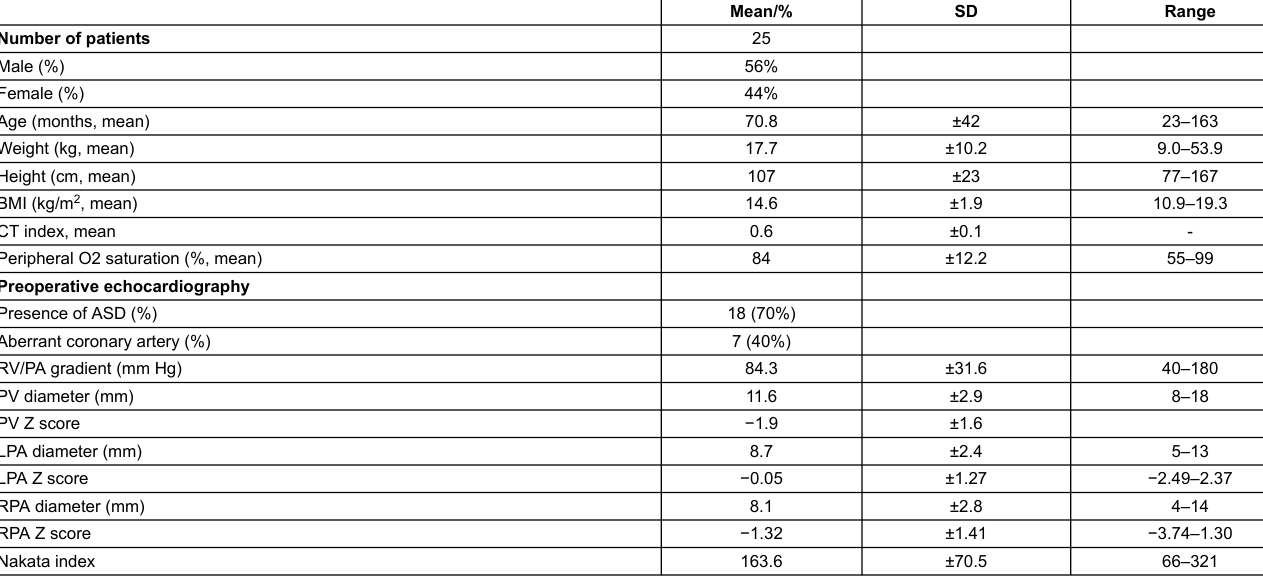
Peripheral O2 saturation (%,